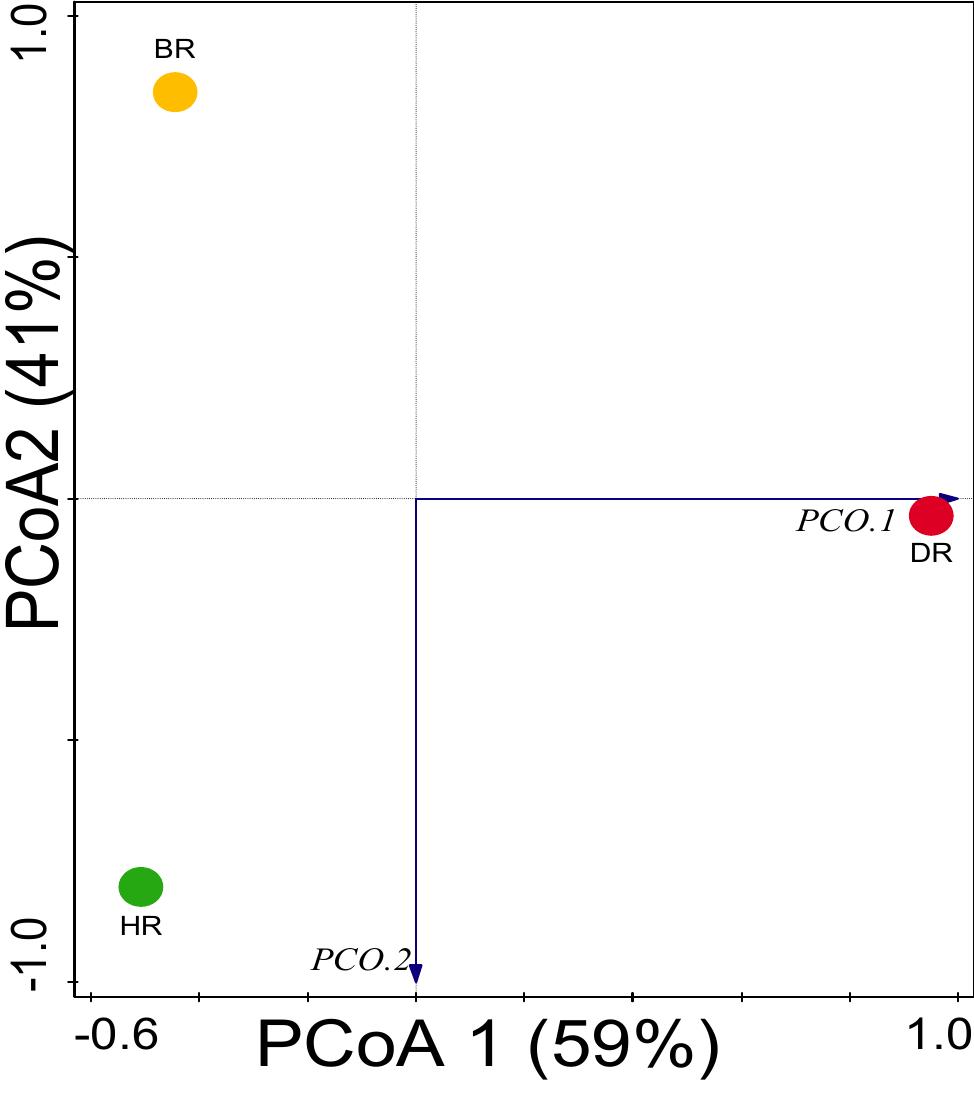
Figure 7. PCoA graph of the community of microbes in the soil based on Bray–Curtis differences. HR = rhizosphere soil of healthy tomato plant; DR = rhizosphere soil of diseased tomato plant; and BR = bulk soil obtained from the soil without tomato plantation.